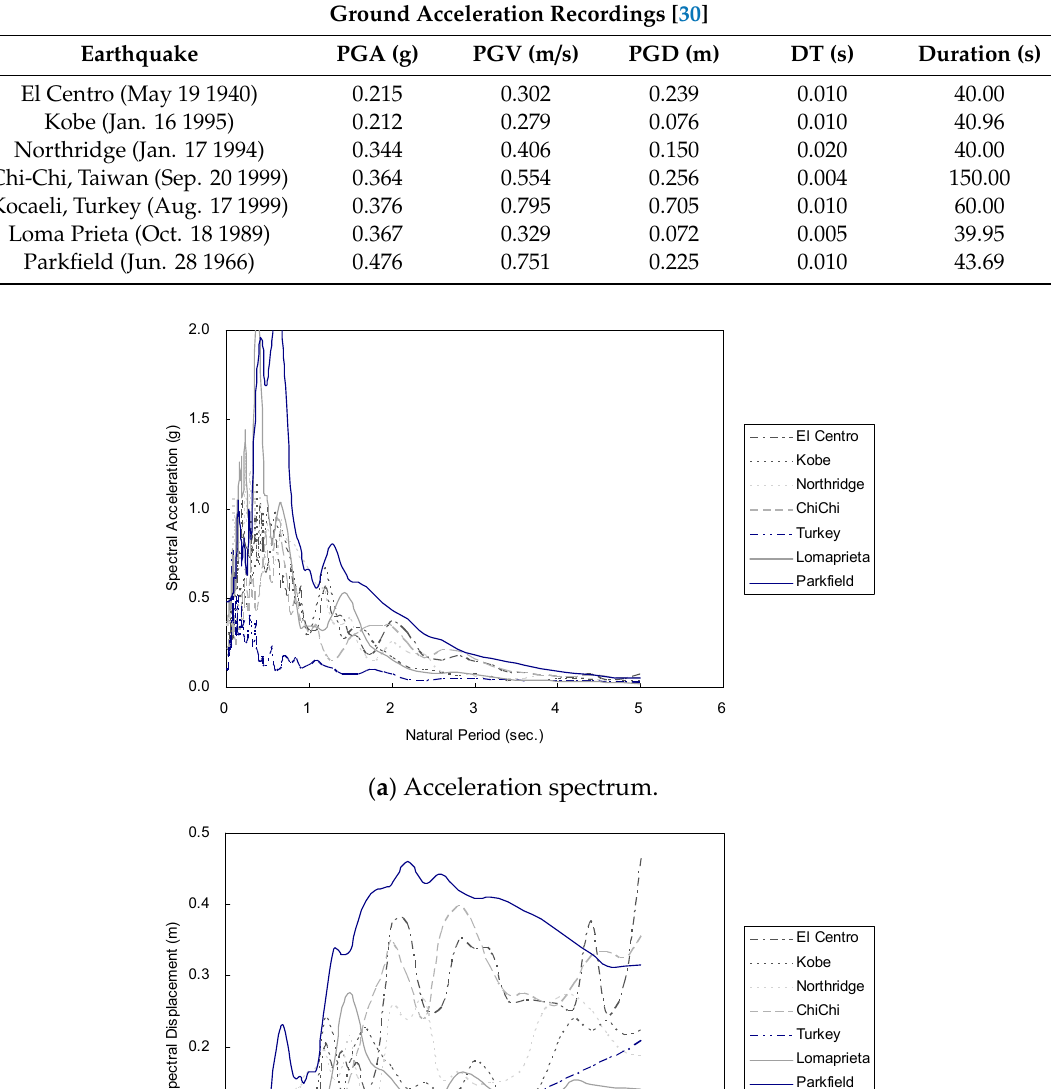
Table 3. Input ground excitation data for the time-history analysis.